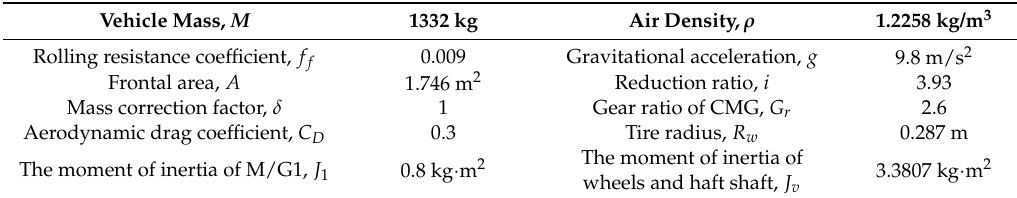
Table 7. Modeling